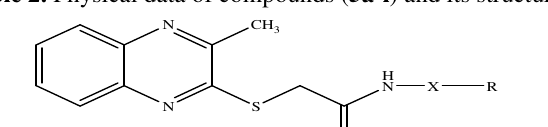
Table 2. Physical data of compounds ( 5a-l ) and its